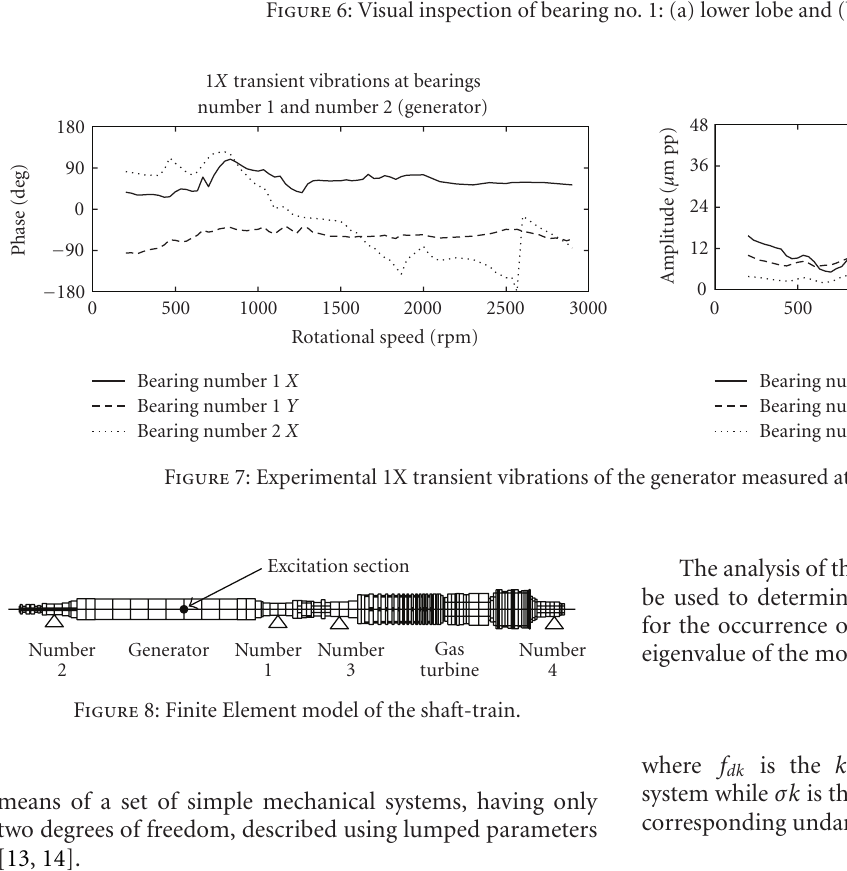
Figure 6: Visual inspection of bearing no. 1: (a) lower lobe and (b) upper lobe.